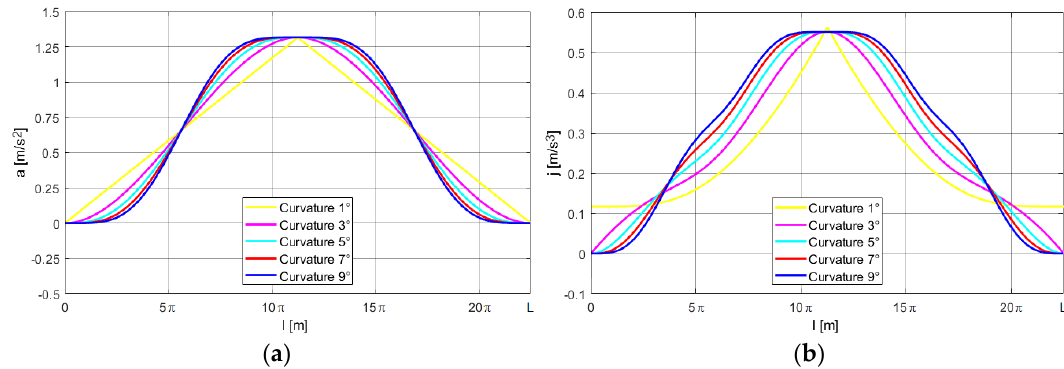
Figure 12. The course of the resultant kinematic quantities for the RHO trajectory: ( a ) acceleration; ( b )